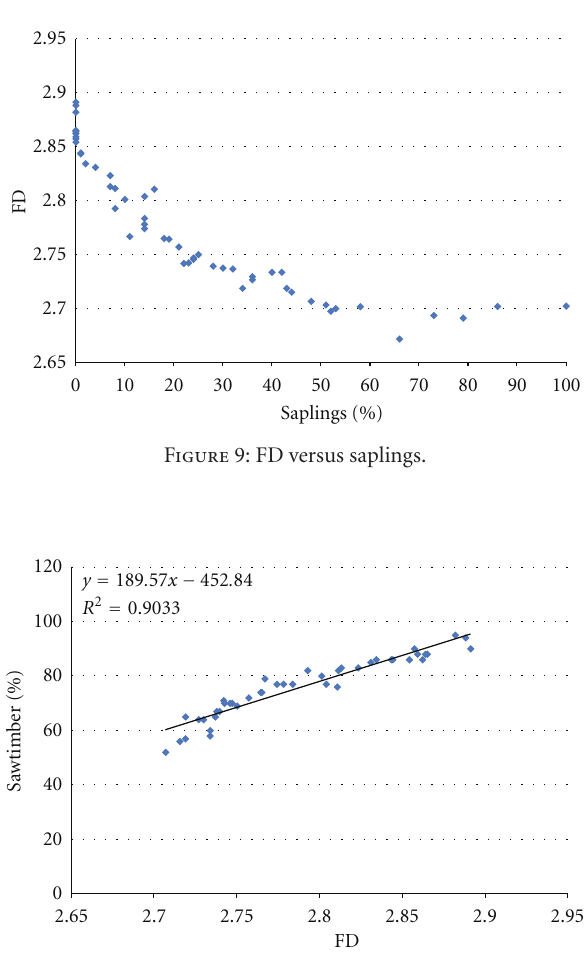
Figure 10: FD versus sawtimber (bounds excluded).